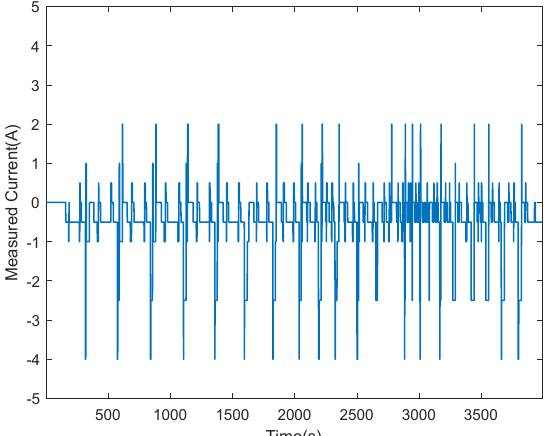
Figure 14. Relative error during dynamic current.